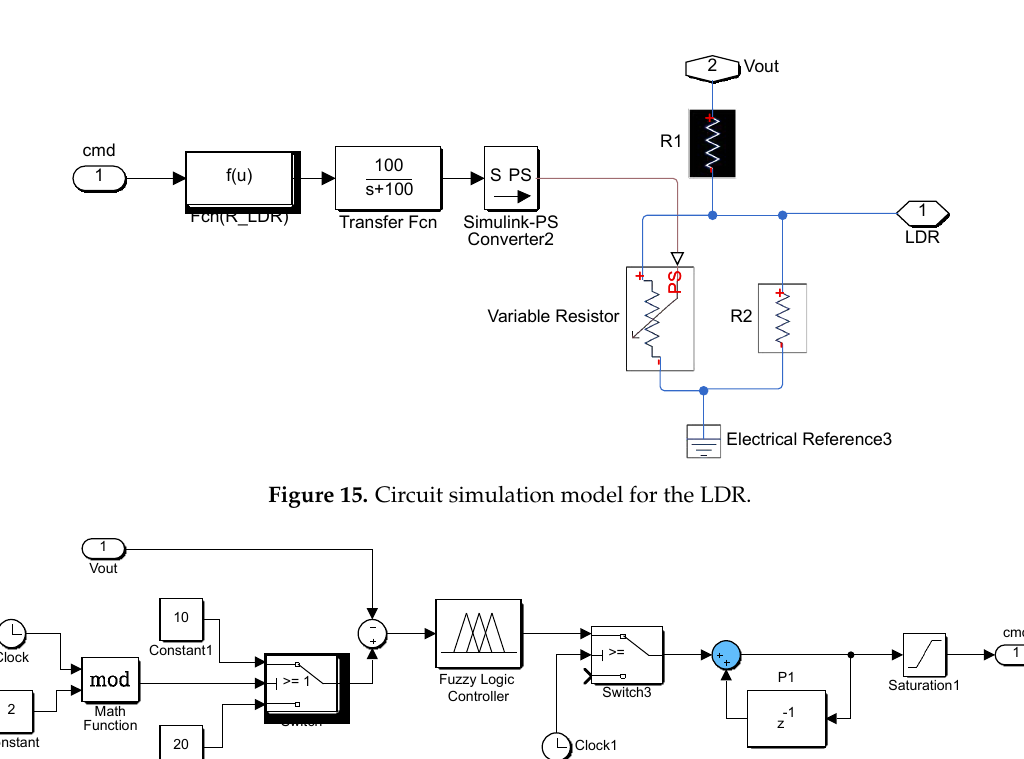
Figure 16. Fuzzy controller for voltage regulation simulation.